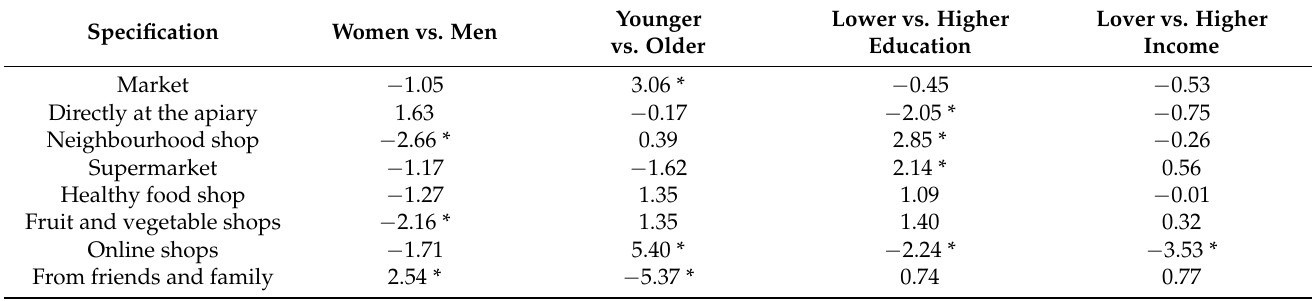
Table 5. Determinants of ways of obtaining/purchasing honey ( n = 434, Mann–Whitney test).